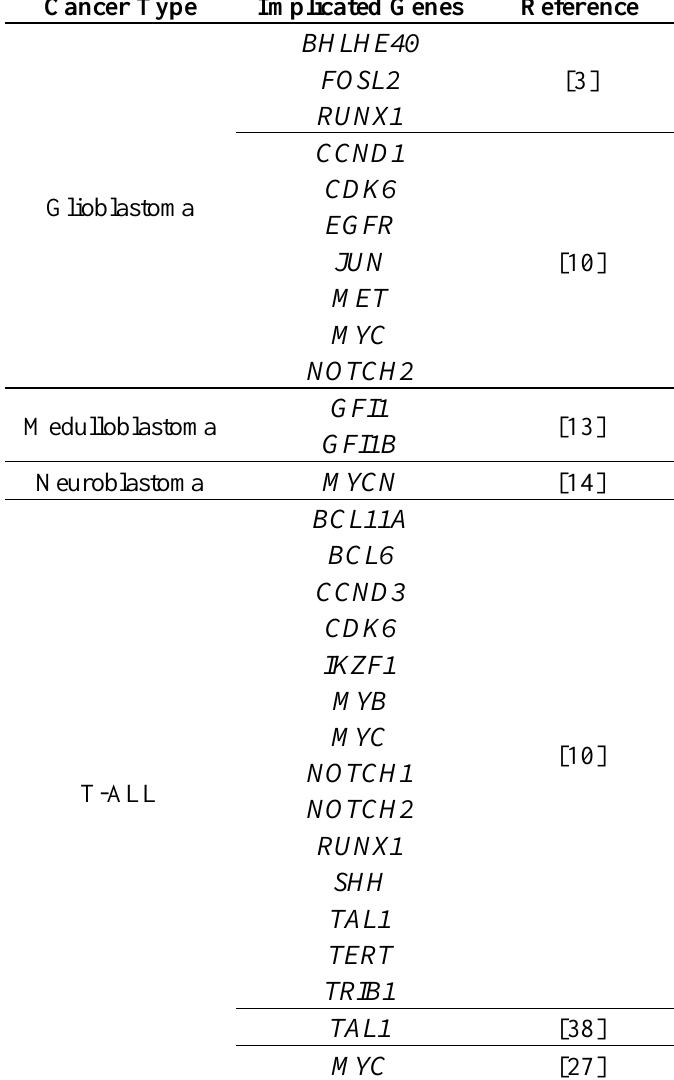
Table 4. Selected Pediatric Cancer Super-Enhancers and their implicated